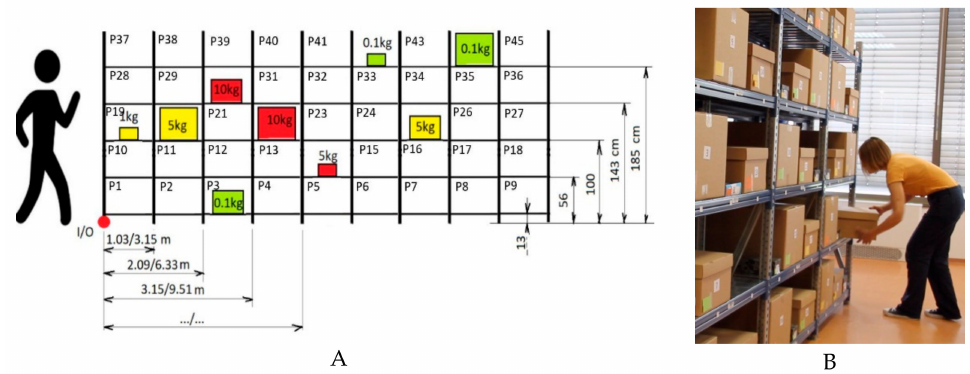
Figure 3. The case study’s storage rack: ( A )—technical data; ( B )—placement in the laboratory. Two different lengths of storage rack are analyzed—the first one with 1.06 m spacing between rack holders and the other with 3.18 m spacing. The box is always stocked in the middle of two rack holders. Distances between the depot (I/O) and the end of a specific position from P1 to P9 are also shown in (Figure 3A).